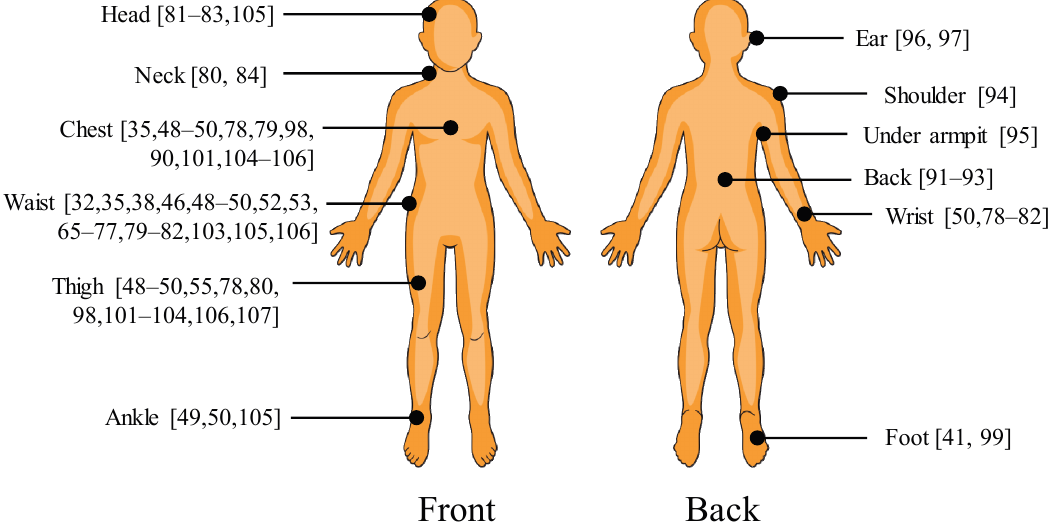
Figure 2. Different positions for sensor